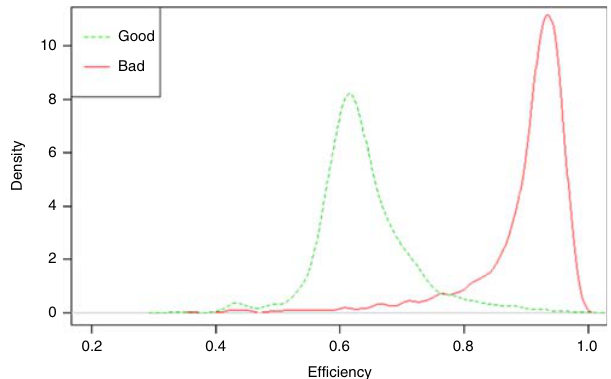
Figure 1. Efficiency under DDF